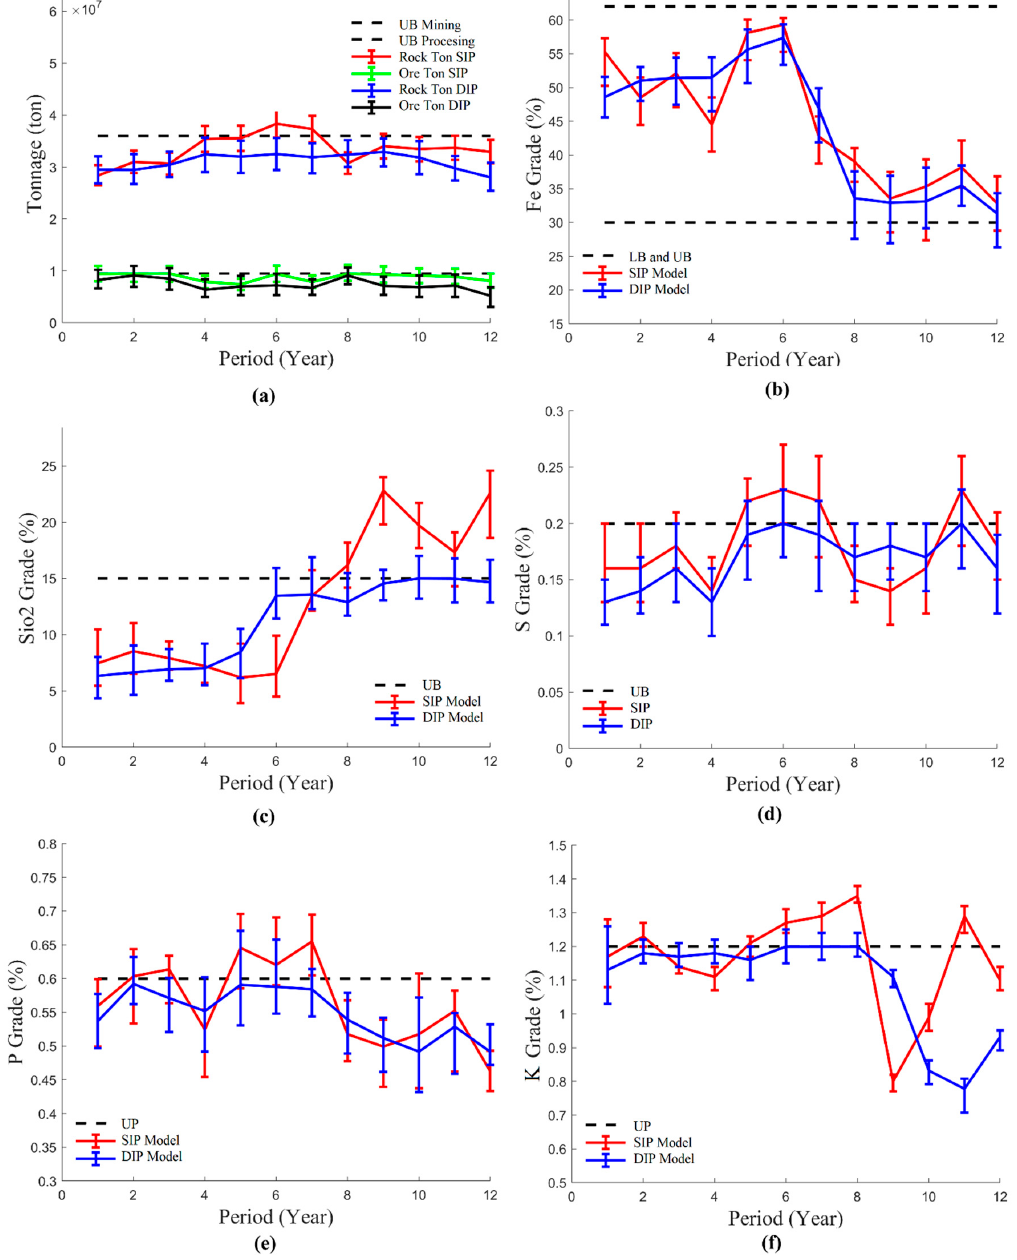
Figure 8. Production plan obtained from the stochastic integer ‐ programming (SIP) and deterministic integer programming (DIP) models: ( a ) ore and rock tonnes, and grades of ( b ) iron, ( c ) silica, ( d ) sulfur, ( e ) phosphorus, and ( f ) potassium. The error bars represent the P5 and P95 values obtained on the set of simulated block models; the continuous lines represent the average (expected) values.